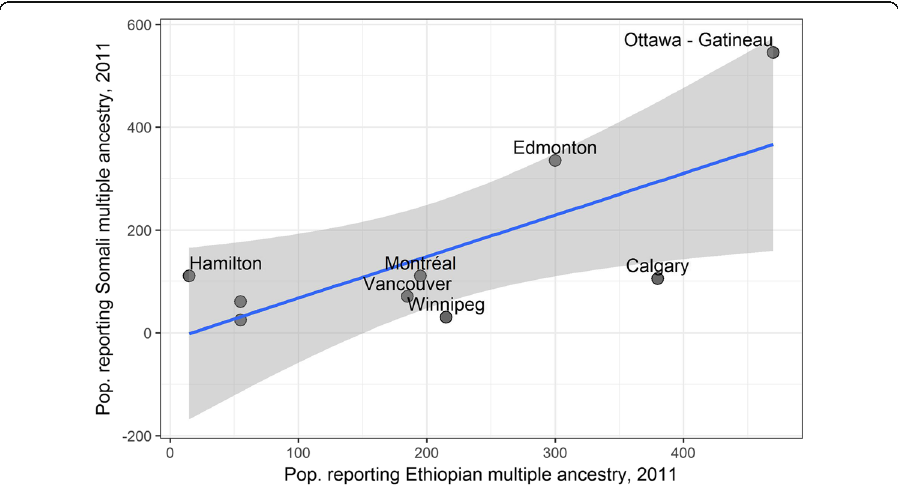
Fig. 11 Population reporting Somali multiple ethnicity plotted against population reporting Ethiopian multiple ethnicity in 2011, selected metropolitan areas (excluding Toronto). Blue line indicates linear regression fit, and grey area is 95% confidence interval for the regression